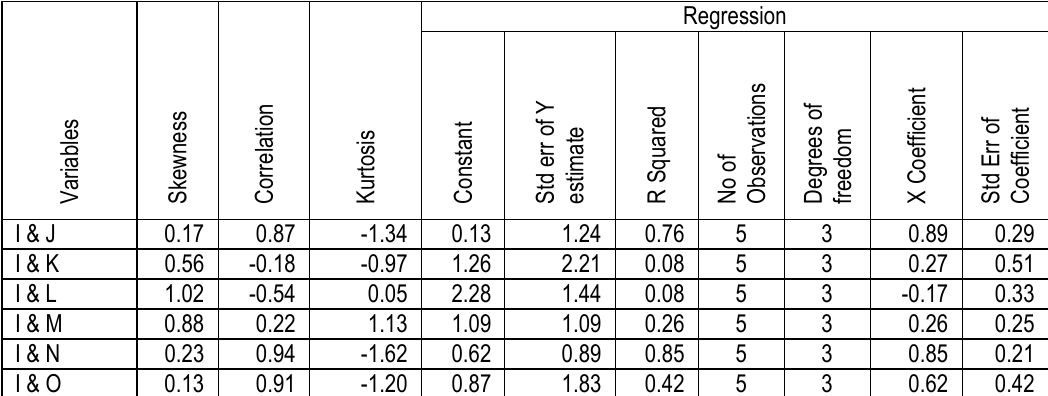
Table 8. Relationship of Examination with other